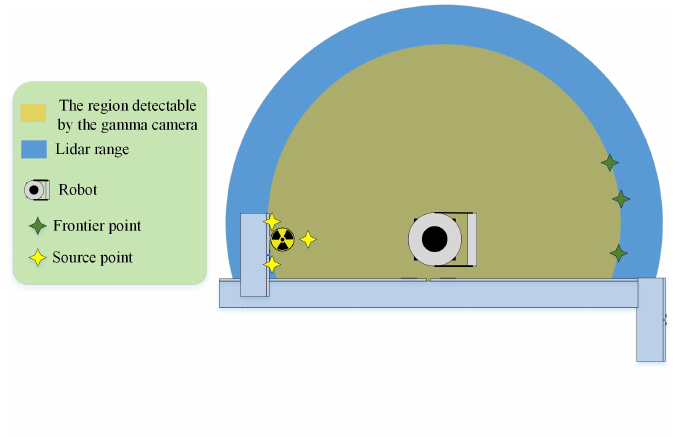
Figure 4. Candidate points are as follows: frontier points on the boundary of the minimum map and points around possible sources. The minimum map is a combination of the obstacle and radiation covering